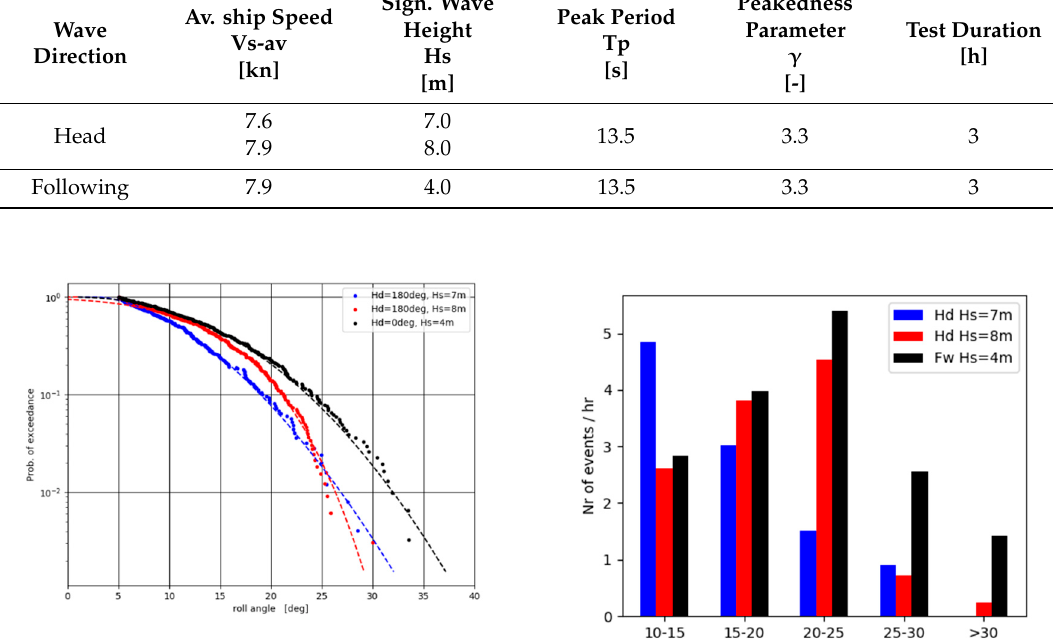
Figure 6. Results of the experiments in three sea states; two head waves (HW) and one following wave (FW), all at a speed of about 8 kn. One realisation of the wave with a duration of 3 h was run in the experiments. Left: probability of exceedance of extreme values of the roll motions. Right: number of parametric roll events per hour divided in classes of roll